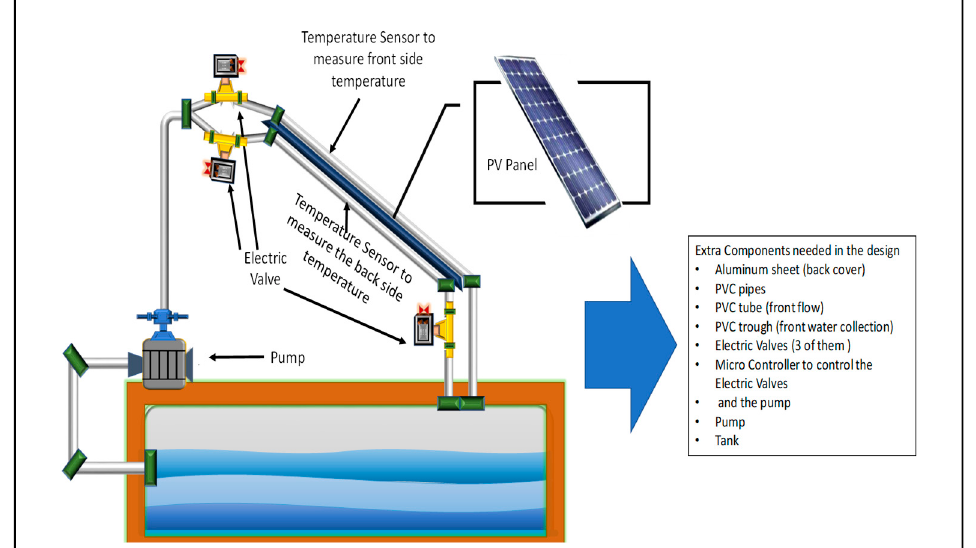
Figure 1. The configuration of the experimental setup.